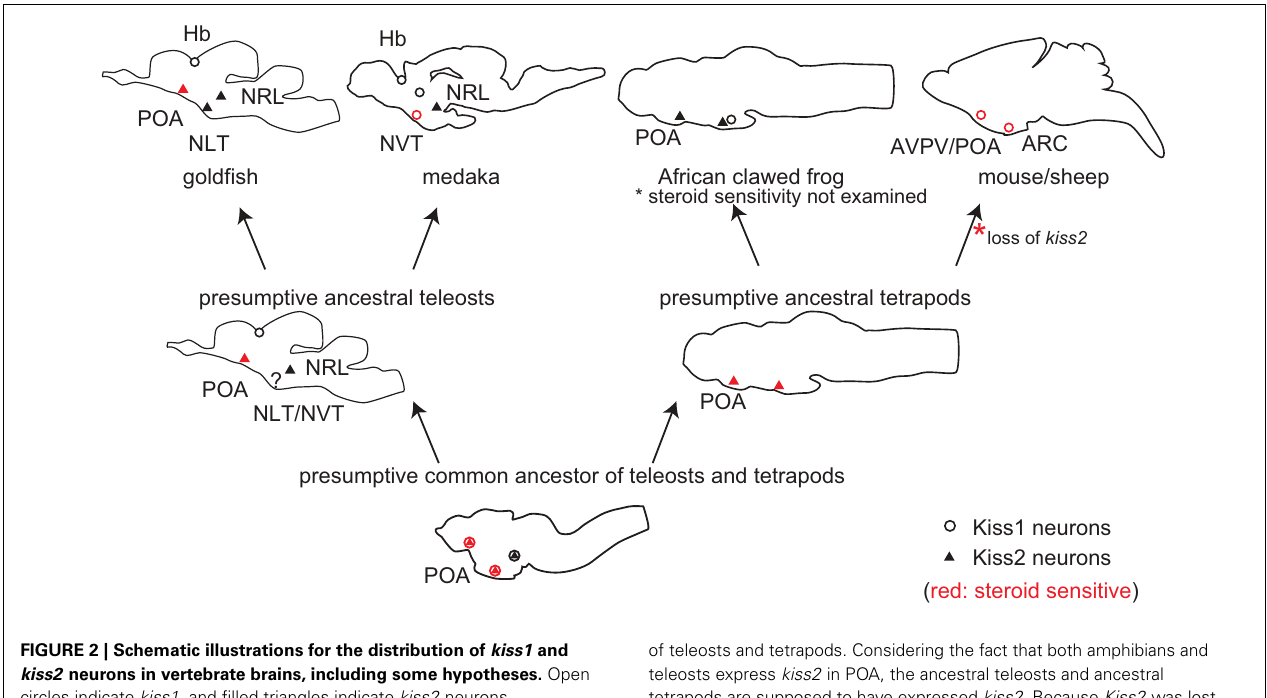
FIGURE 2 | Schematic illustrations for the distribution of kiss1 and kiss2 neurons in vertebrate brains, including some hypotheses. Open circles indicate kiss1 , and filled triangles indicate kiss2 neurons. Circles/triangles in red are kiss1 / kiss2 neurons that are steroid sensitive. Because kiss1 and kiss2 are duplicated sister genes, they are considered to have been co-expressed in the same neurons in the common ancestor